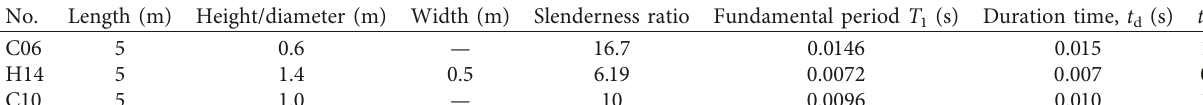
Table 2: Parameters of bridge columns.